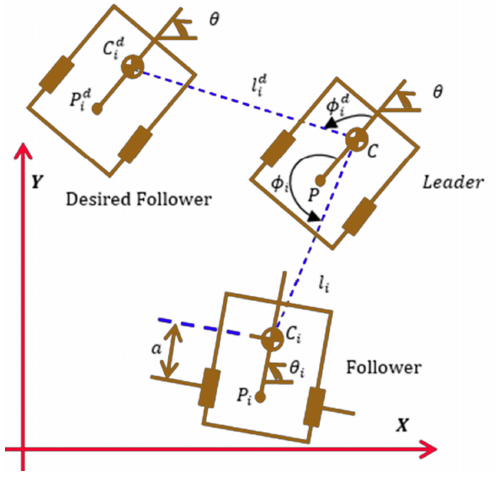
Figure 4. Formation control